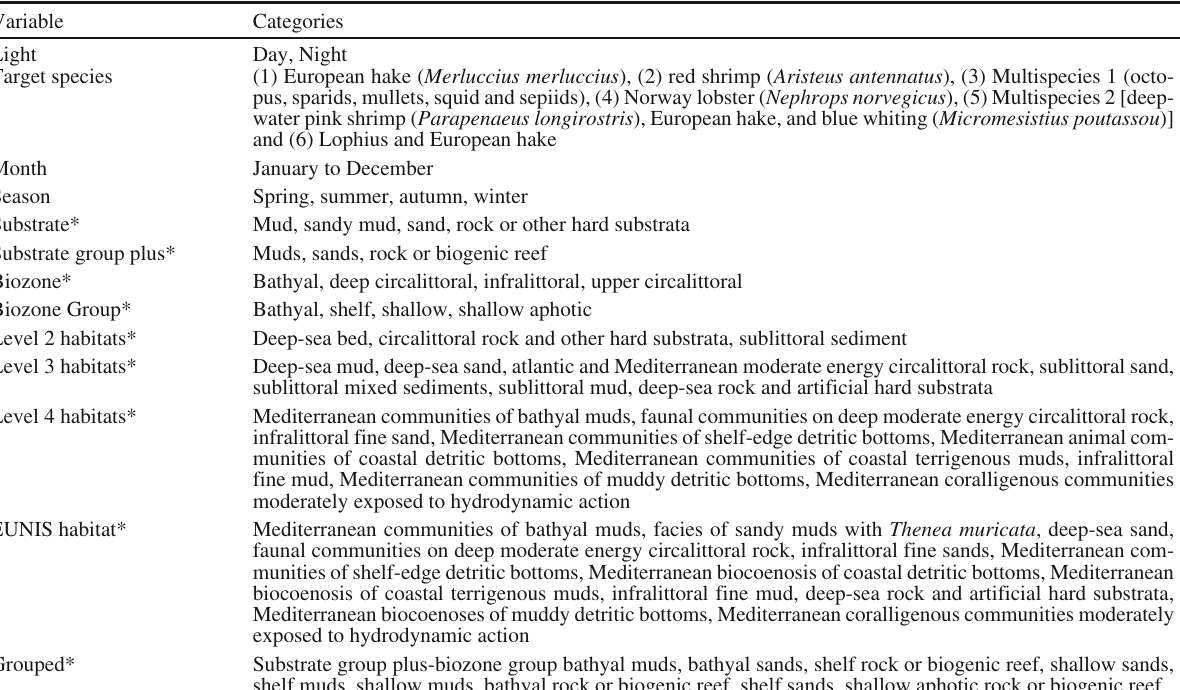
Table 2. – Categorical variables. * Variables from the EUNIS Habitat